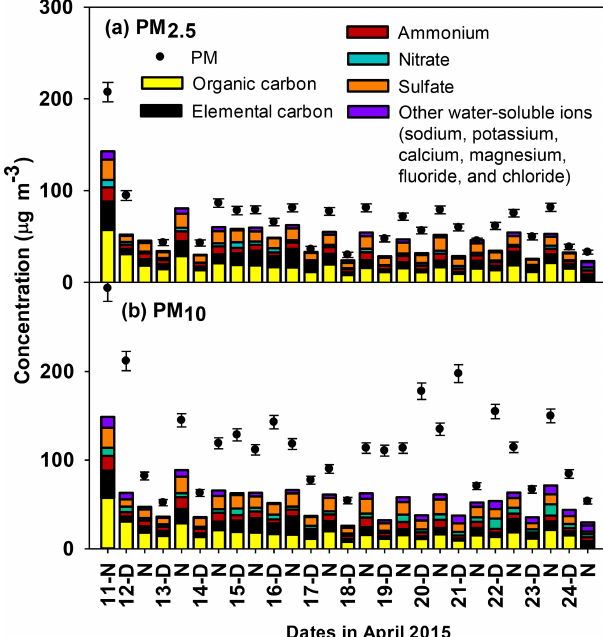
Figure 1. Non-water mass concentrations of (a) PM 2 . 5 and (b) PM 10 during daytime and nighttime periods and mass contributions from OC, EC, and inorganic ions. OC and EC were not measured in PM 10 samples and were assumed to be the same as PM 2 . 5 for mass balance purposes. The remaining mass of PM 2 . 5 includes elements associated with OC (hydrogen, oxygen, nitrogen, etc.), metals, and other unmeasured species. Error bars represent propagated analytical uncertainties. The PM 2 . 5 mass was not quantified for nighttime samples collected on 12 April nor 13 April as described in Sect.